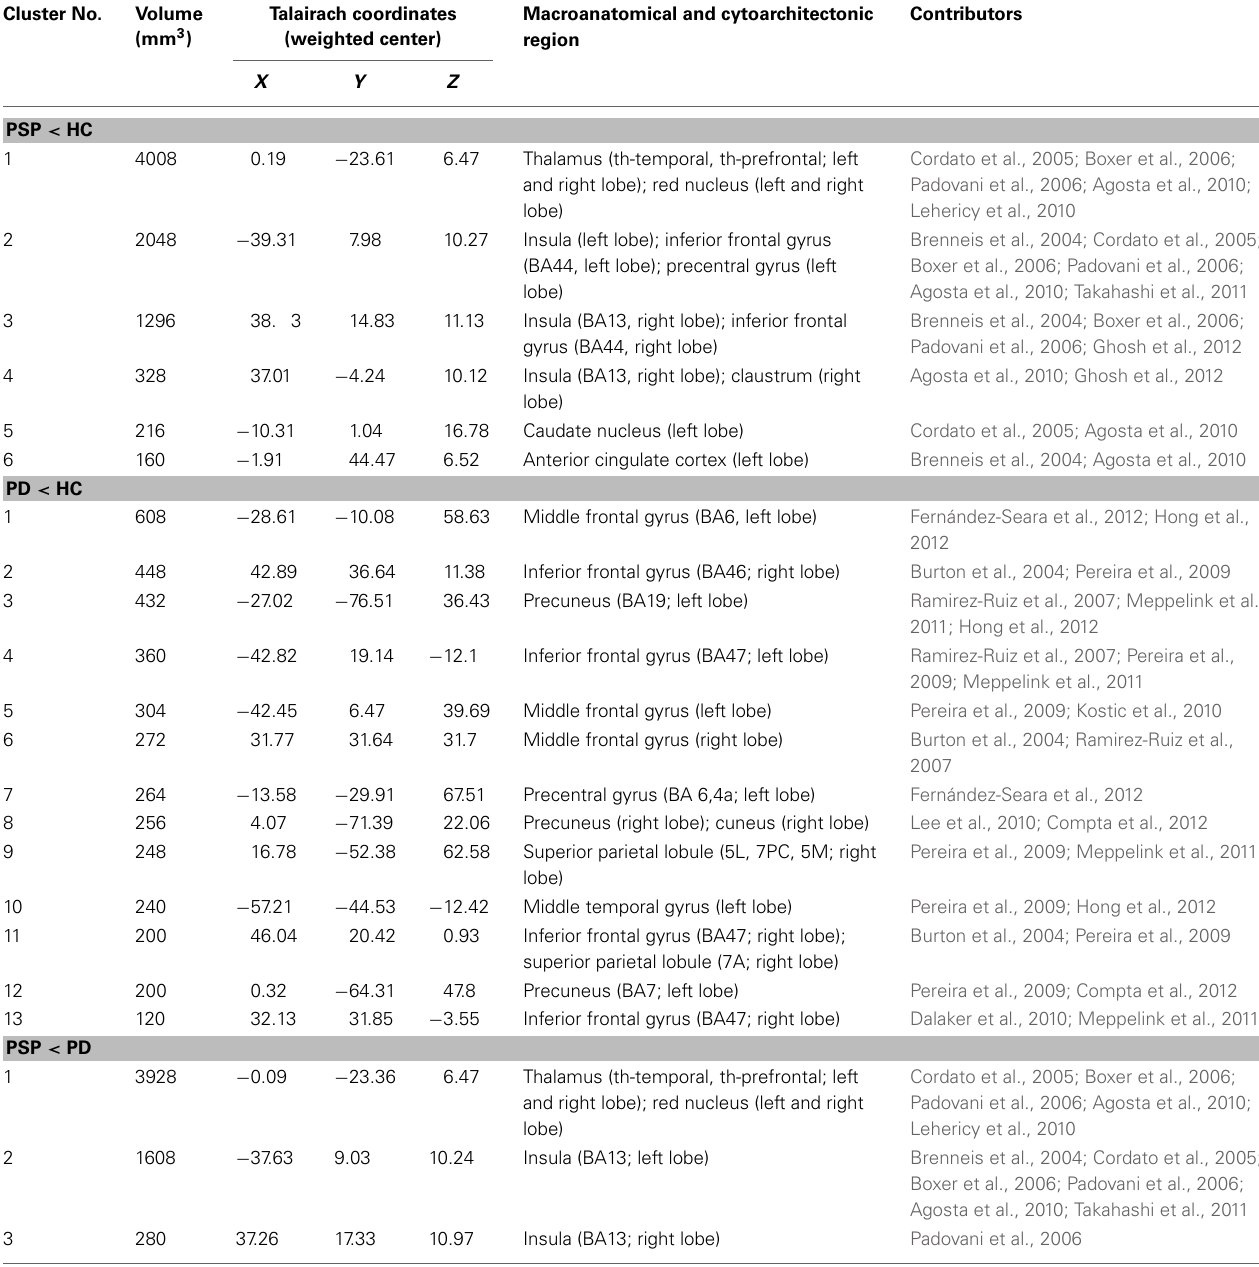
Table 3 | Changes in gray matter volume. Cluster